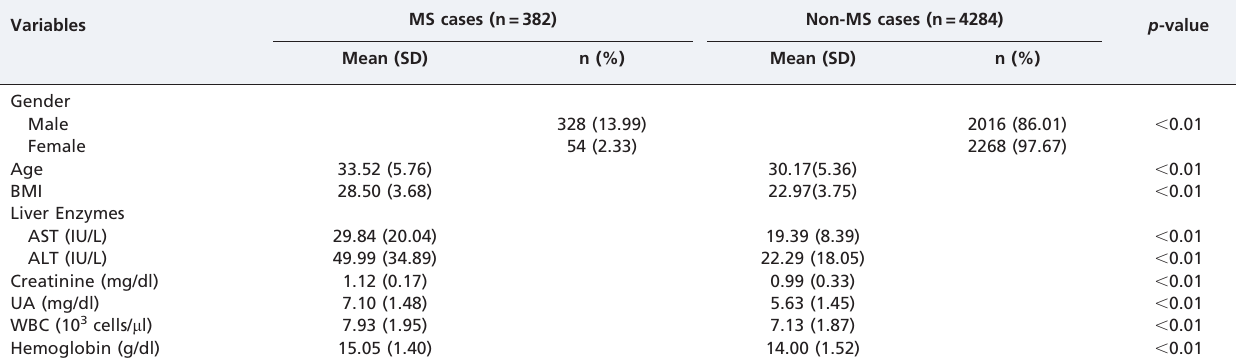
Table 1 - Characteristics of study participants.